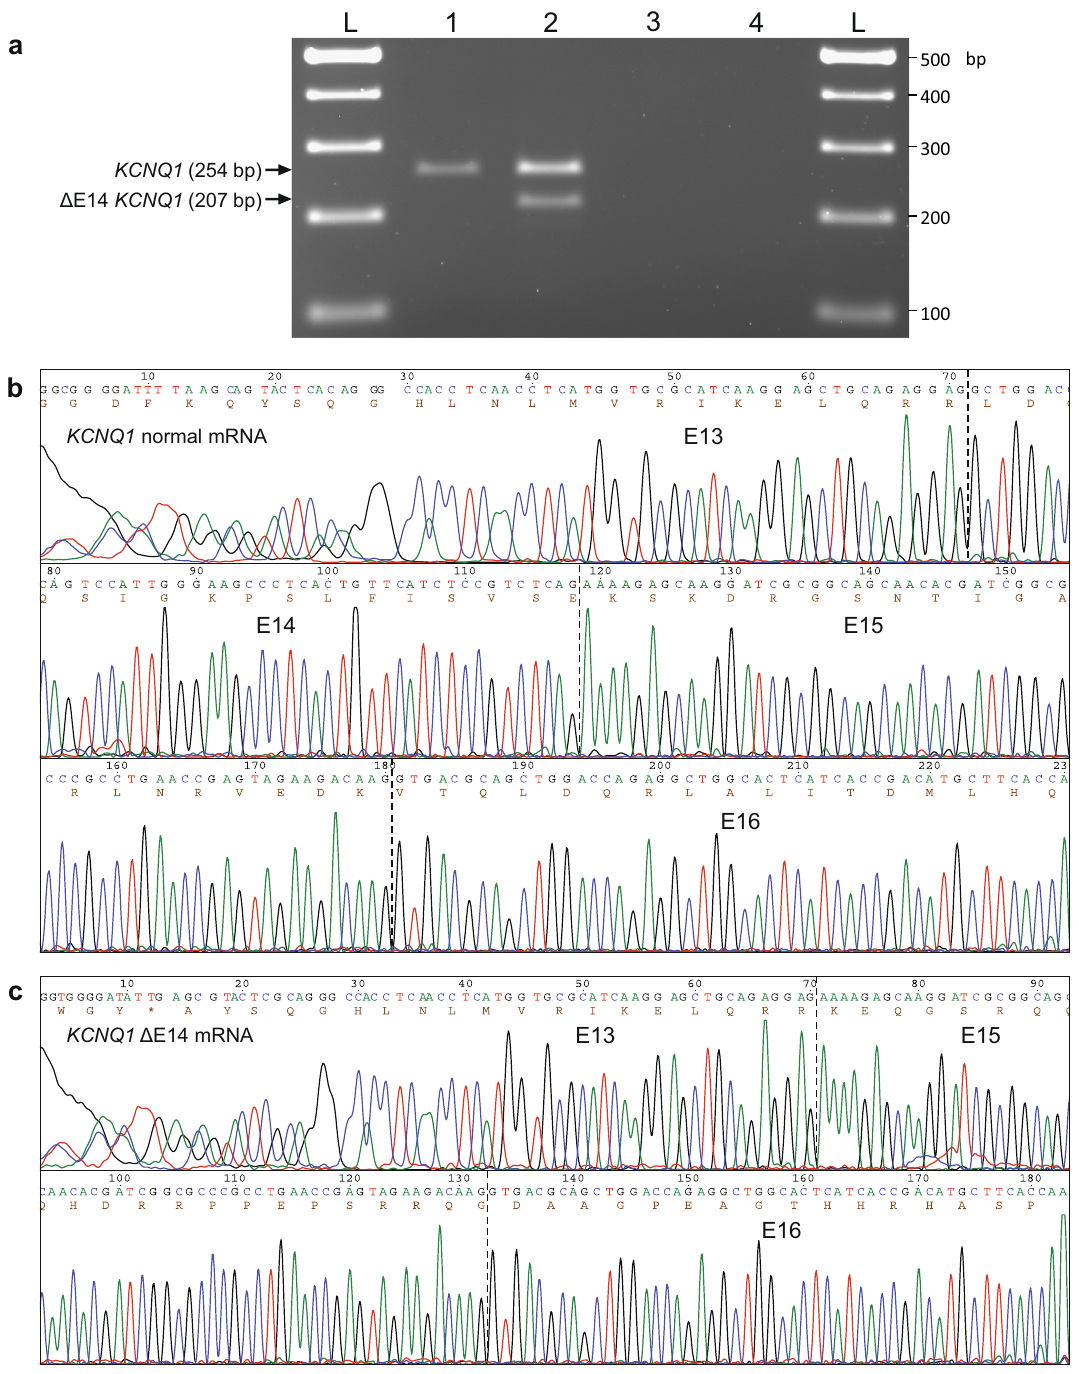
Fig. 8 RT-PCR analysis of endogenous expression of KCNQ1 in the blood of the index patient ’ s parents. a Agarose gel electrophoresis of RT-PCR products of blood RNA isolated from the index patient ’ s mother (lane 1) and father (lane 2). Ampli fi cation of KCNQ1 cDNA was performed with a forward primer located in E13 and a reverse primer in E16. Negative controls were loaded in lane 3 (-RT) and 4 (nontemplate). The upper bands (254 bp) correspond to normal KCNQ1 mRNA and the lower one (207 bp) to the Δ E14 KCNQ1 aberrant mRNA. Below are shown the Sanger sequencing chromatograms of the 254 bp ( b ) and 207 bp ( c ) RT-PCR bands from the index patient ’ s father. The exon-exon junctions are marked with vertical dotted lines, and the number of each exon is indicated (E13-E16). The deduced amino acid sequence is shown below the nucleotide sequence, revealing the frameshift at the start of E15 that was created by the skipping of E14. Full- size RT-PCR image is shown in Supplementary Fig.